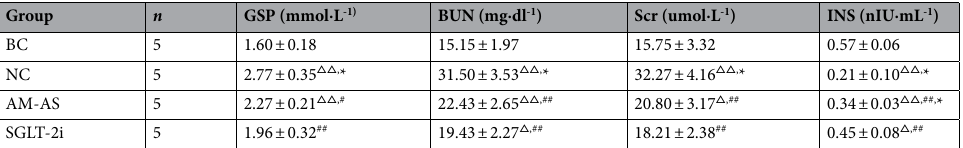
Table 5. Medical laboratory examination of serum ( X ± S ). △△ P < 0.01 vs. BC, △ P < 0.05 vs. BC, ## P < 0.01